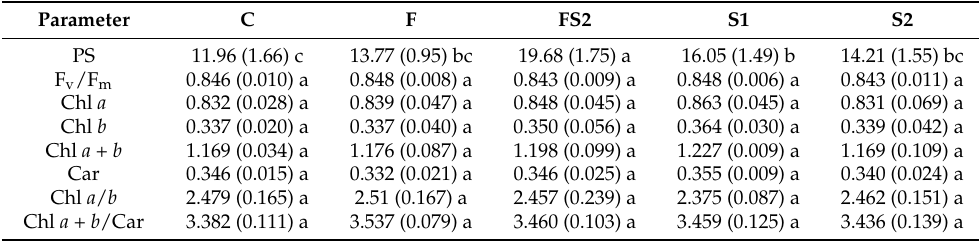
Table 6. Photosynthetic parameters in bean leaves cultivated in: control soil (C—without EAF slag or NPK fertilizer), soil enriched with synthetic NPK fertilizer (F), soil enriched with a combination of 2% EAF slag and NPK fertilizer (FS2), and with EAF slag (S1—1%, S2—2%